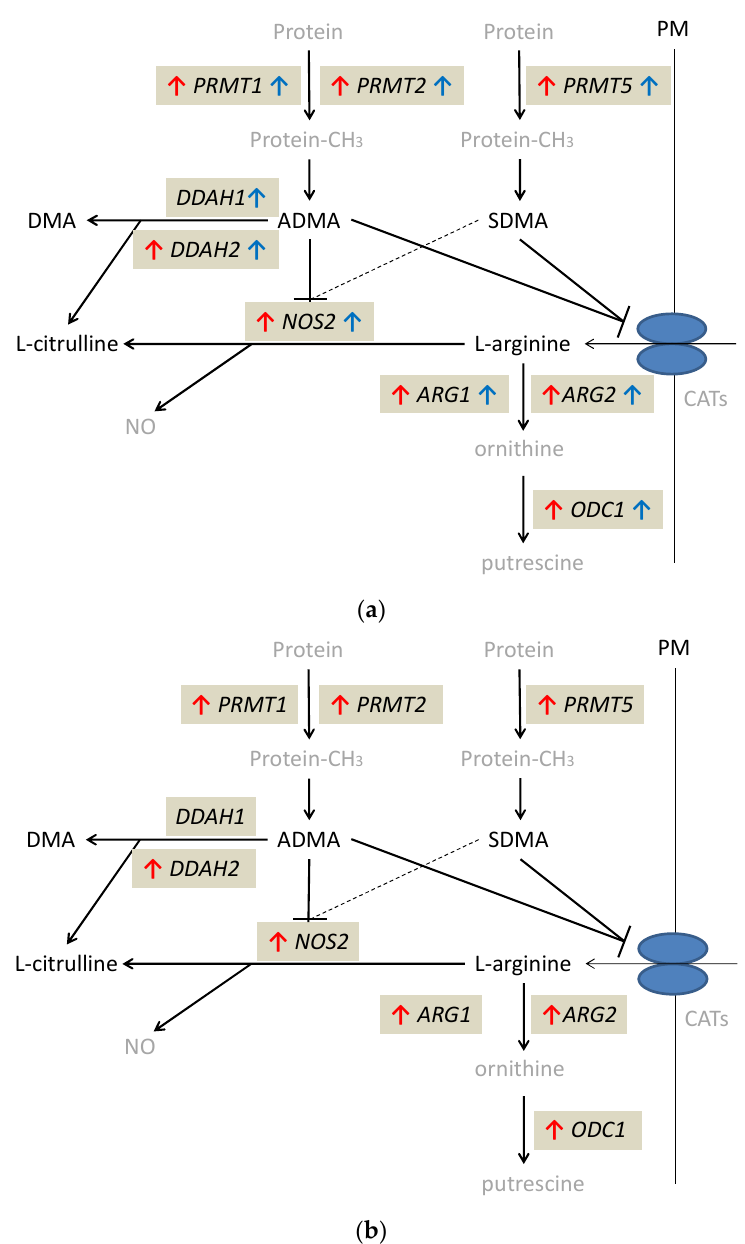
Figure 4. Alterations in expression of L-arginine/NO pathway enzymes: (a) in inflamed and quiescent tissue from patients with Crohn’s disease as compared to normal large bowel tissue derived from patients undergoing polypectomy; (b) in inflamed tissue from patients with ulcerative colitis as compared to normal large bowel tissue derived from patients undergoing polypectomy. Changes observed in inflamed large bowel are marked by red arrows and changes observed in quiescent large bowel by blue arrows. Pathway players analyzed in the current study are written in black: metabolites in straight font and enzymes in italics. Inhibition is marked as T-arrows (as a dashed line if the effect is weak). PRMT, arginine N-methyltransferase; PM, plasma membrane; CATs, cationic amino acid transporters; DDAH, dimethylarginine dimethylaminohydrolase; DMA, dimethylamine; ADMA, asymmetric dimethylarginine; SDMA, symmetric dimethylarginine; NOS, nitric oxide synthase; NO, nitric oxide; ARG, arginase; ODC, ornithine decarboxylase; protein-CH 3 , methylated proteins.